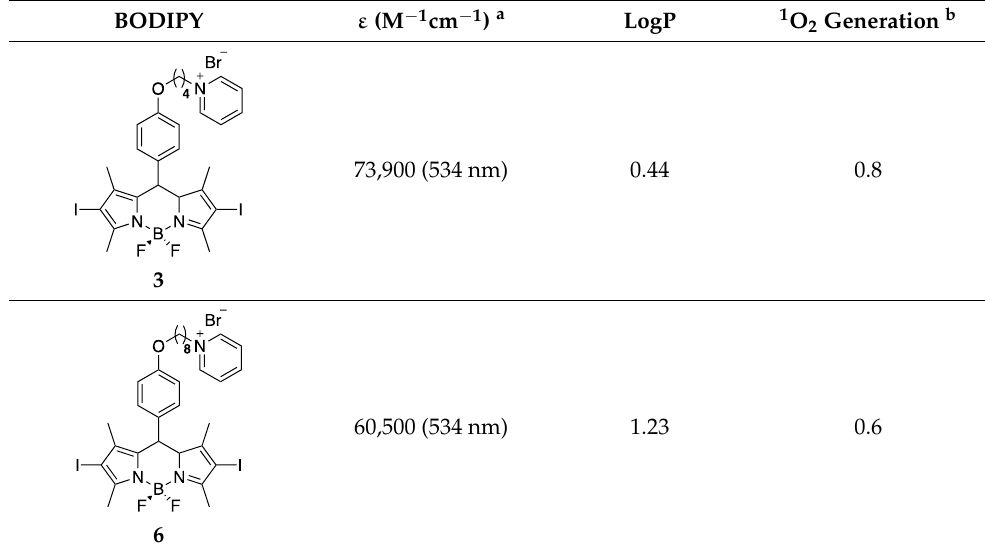
Table 1. Wavelength of maximum absorption and extinction coefficient, partition coefficient octanol/water and 1 O 2 generation for BODIPYs 3 and 6 .